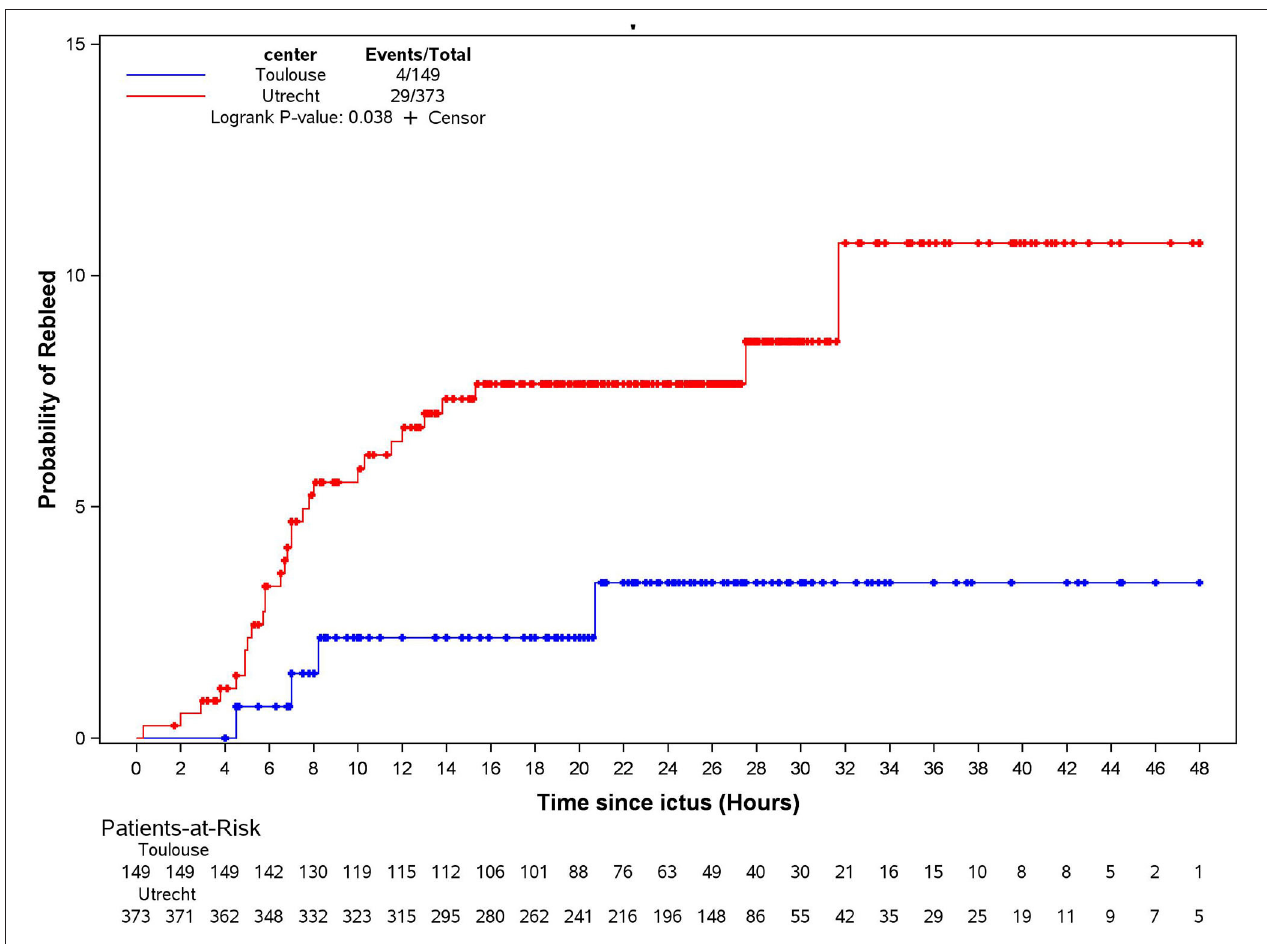
FIGURE 2 | Kaplan–Meier one minus survival curves of time to rebleeding